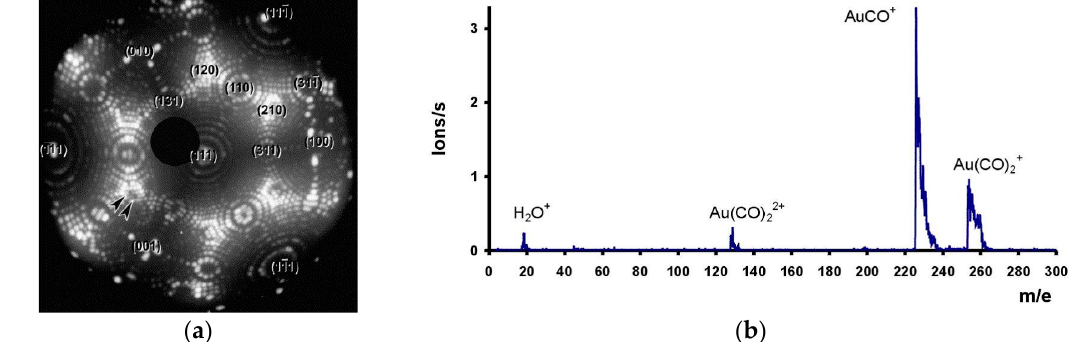
Figure 13. Analysis of a single Au nanoparticle by FIM and 1DAP: ( a ) Field Ion Microscopy (FIM) image of a (111)-oriented Au sample where the atomic resolution can be observed on steps and kinks and inside flat planes of small sizes. The dark circle corresponds to a typical region of analysis for studies by mass spectrometry. The magnification in FIM corresponds to ~10 6 on a detector screen of 3 inches diameter. Conditions of acquisition: T = 50 K, P Ne = 10 − 3 Pa. Reprinted from [204], Copyright 2006, Elsevier; ( b ) Mass spectra of an Au sample during interaction with CO in the presence of an external electric field. Mono- and di-carbonyls are formed on the sample. The region of analysis corresponds to ≈ 400 atomic Au sites. Conditions of acquisition: T = 300 K, P CO = 10 − 3 Pa, steady field F R = 2.1 V/Å, pulsed field F P = 1.1 V/Å, frequency of the field pulses f = 1.67 kHz. Reprinted from [199].